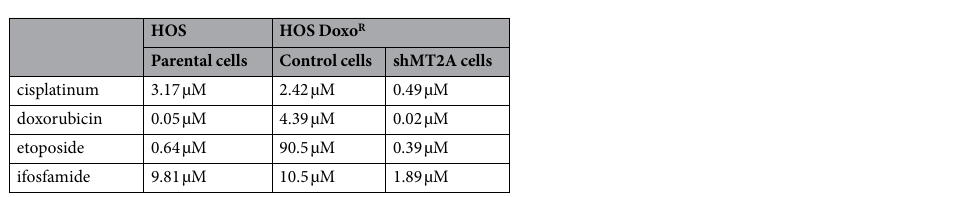
Table 2. Half maximal inhibitory concentrations (IC50) for chemotherapy. Cell viability was assessed in human HOS Doxo R incubated for 72 hrs in the presence of increasing doses of each indicated